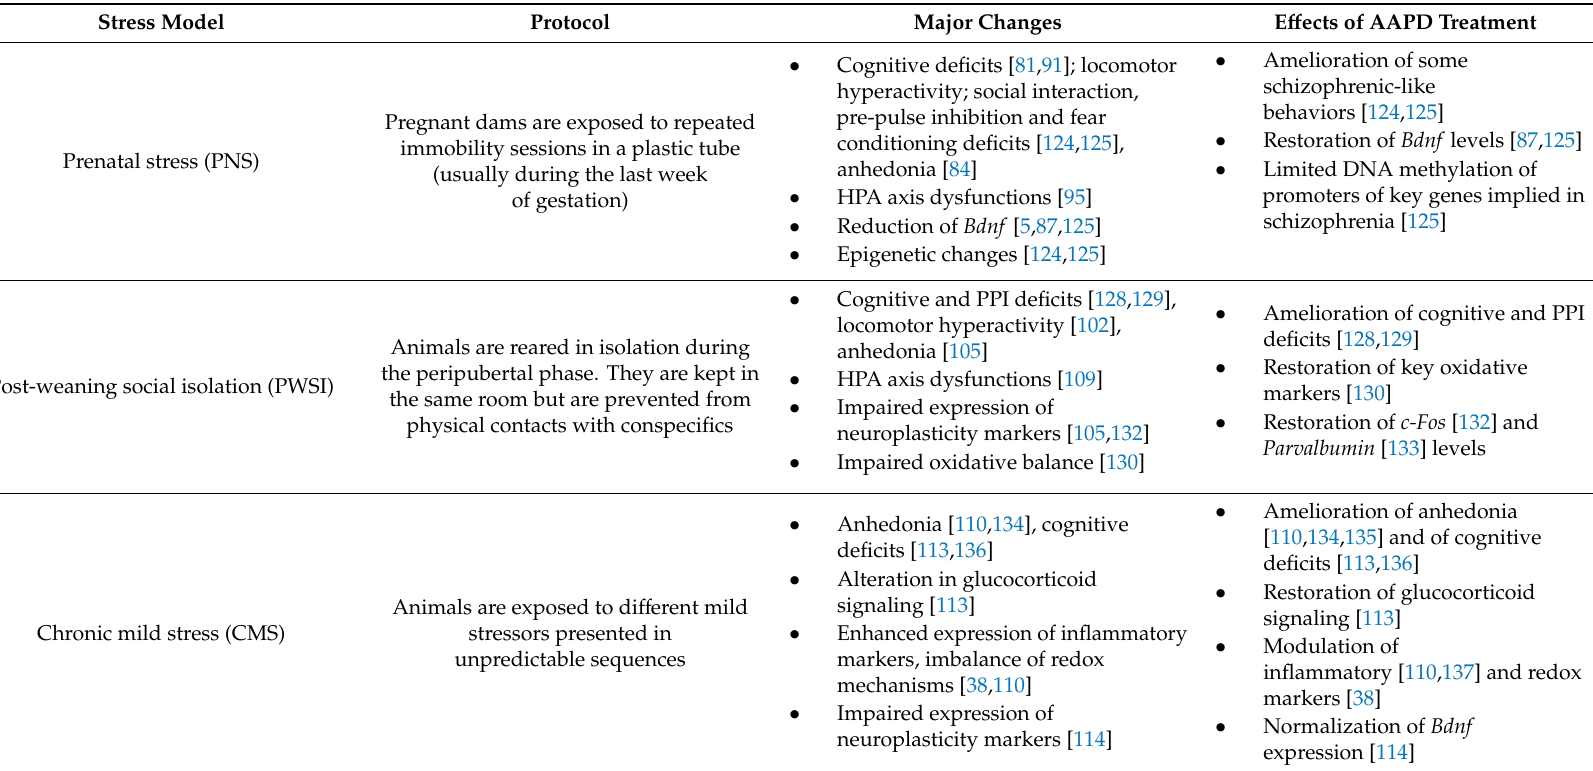
Table 1. Behavioral and molecular changes in stress-based animal models of psychiatric disorders and their modulations following atypical antipsychotic drug (AAPD)